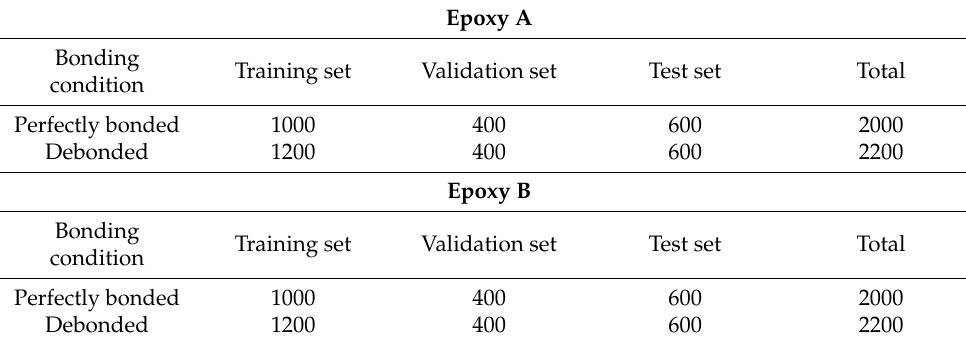
Table 7. Distribution of the